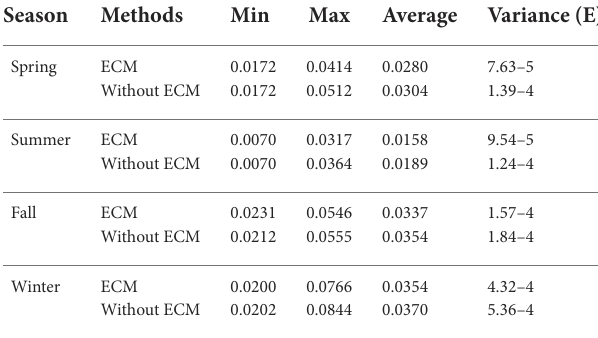
TABLE 1 Statistical results of daily MAPE result for the effect of ECM in various